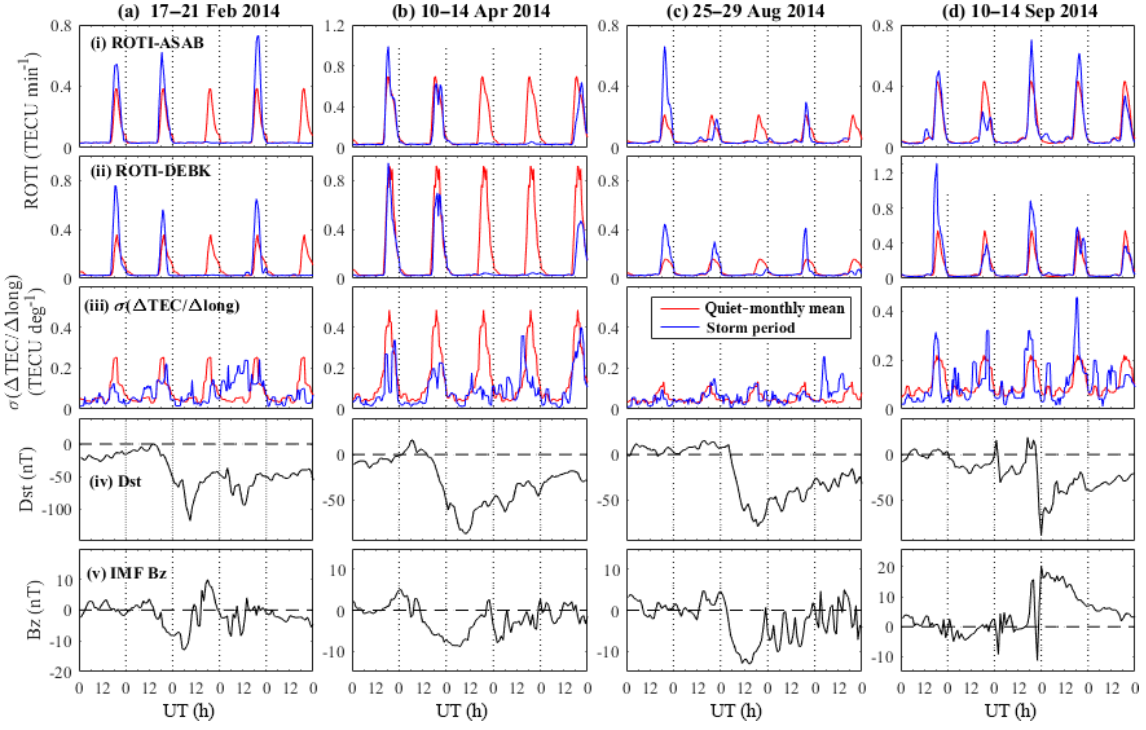
Figure 5. Variation of ROTI over (i) ASAB and (ii) DEBK, and (iii) σ((cid:49) TEC /(cid:49) long ) during geomagnetic storms (blue curves): (a) 17– 21 February 2014, (b) 10–14 April 2014, (c) 26–29 August 2014 and (d) 10–14 September 2014 with respect to the quiet-monthly mean (red curves). Local time (LT) = UT +